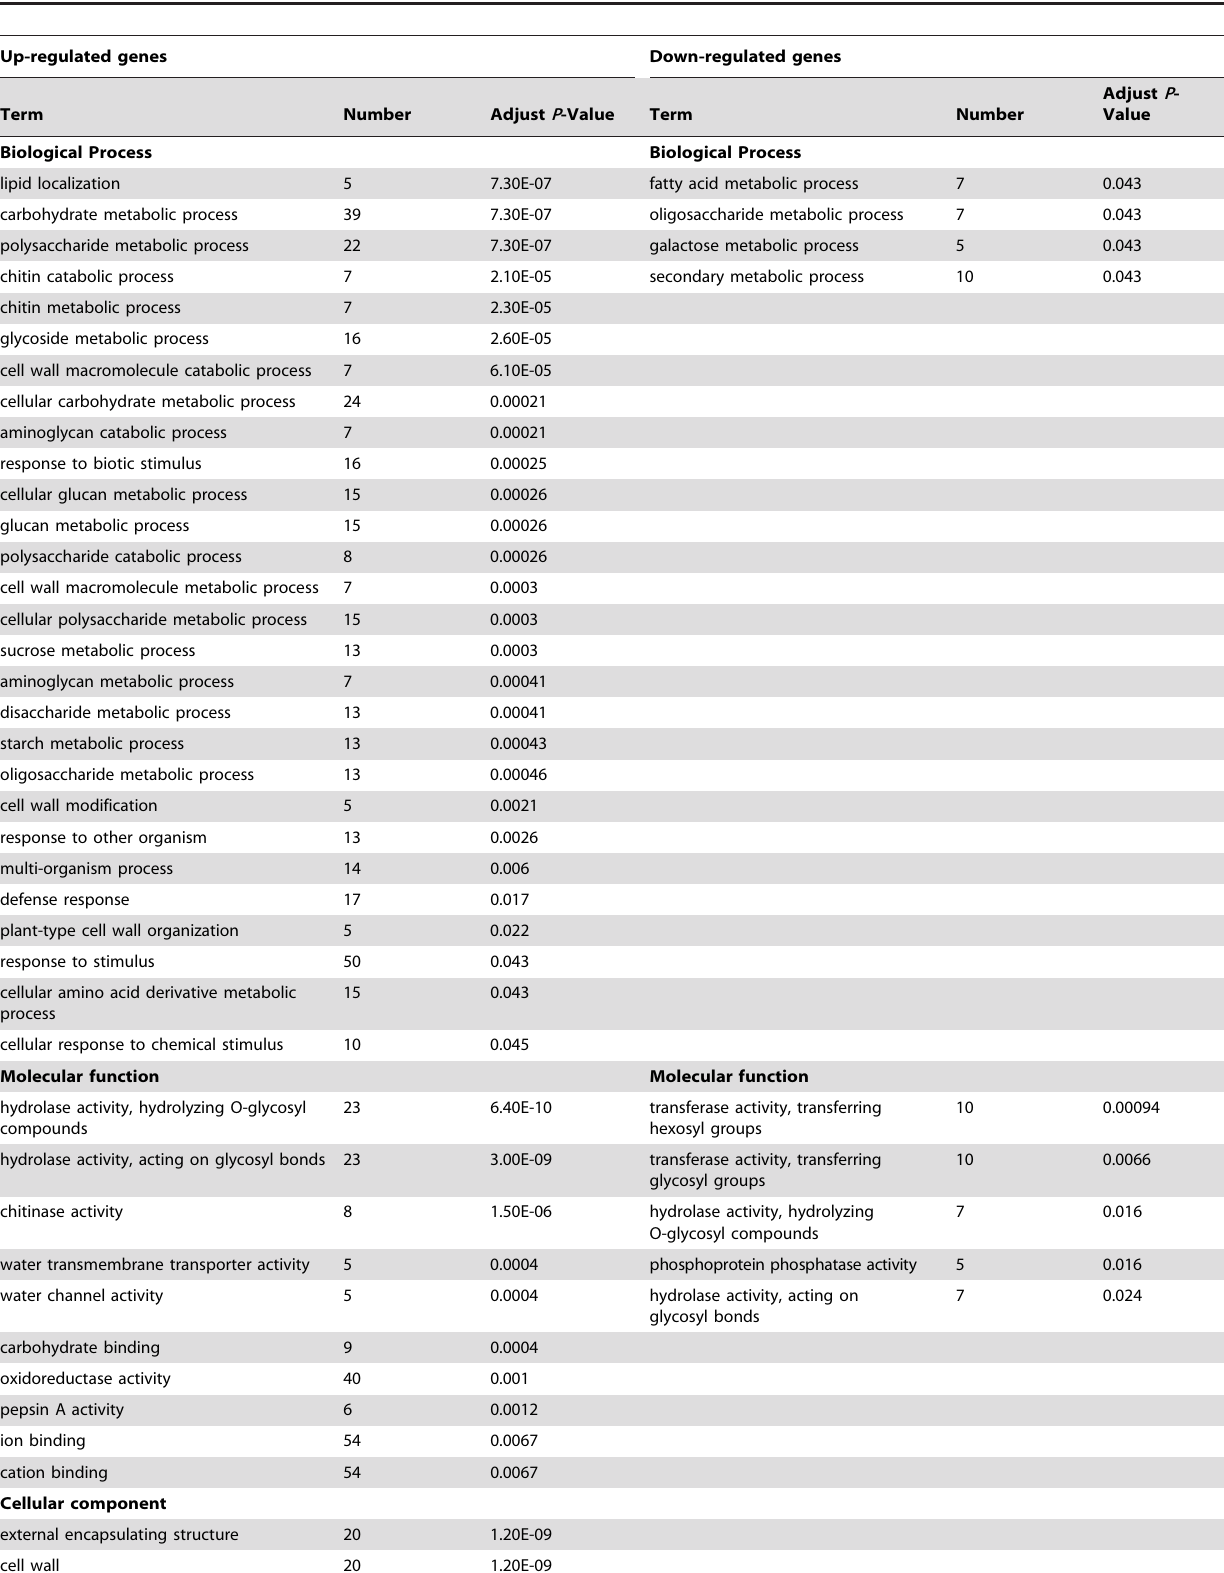
Table 2. Significantly enriched GO terms (adjust P , 0.05) of specifically regulated genes in ‘Meiwa’ after Singular Enrichment